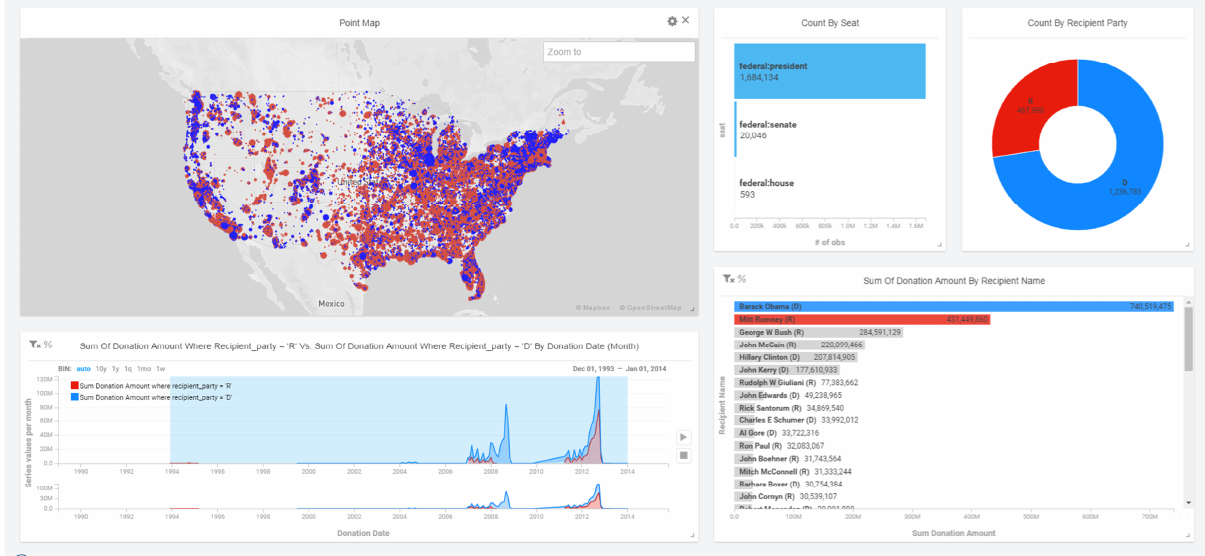
Figure 6: The MapD interface, facilitating a closer look at donations to campaigning politicians in the election cycle of 2012, utilizing a point map, a timeline, as well as bar and ring charts for the parallel view on the same phenomenon